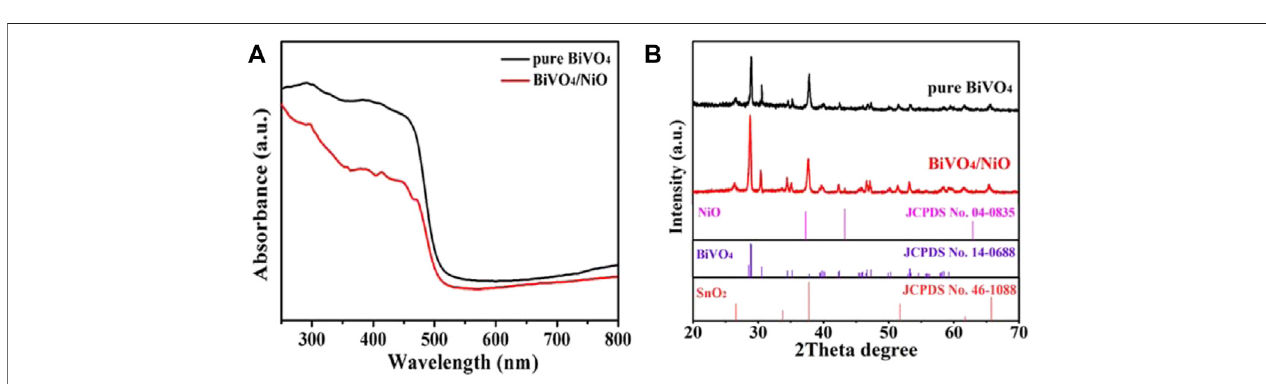
FIGURE 2 | (A) UV − Vis diffuse re fl ectance spectra of BiVO